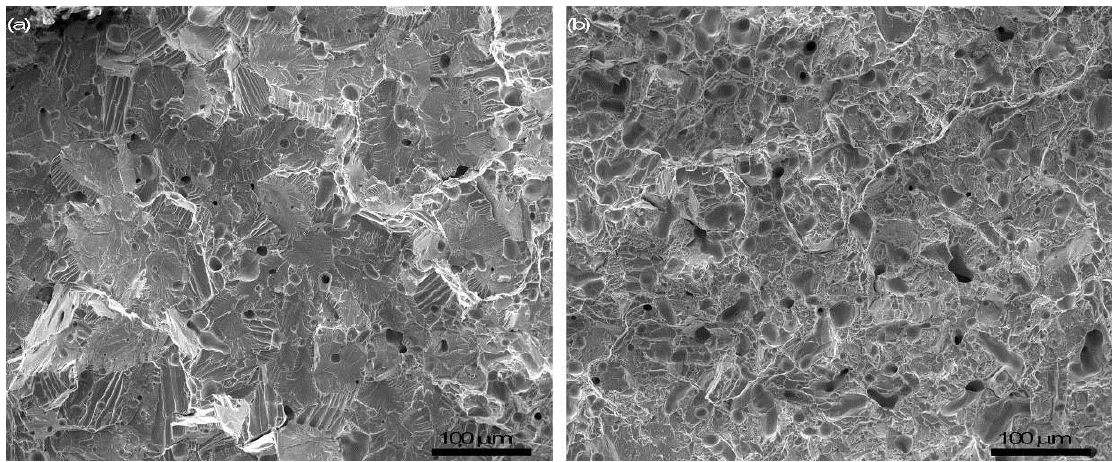
Figure 8. Fracture surfaces of tensile slices from sintered titanium samples: ( a ) S4 and ( b ) S5.